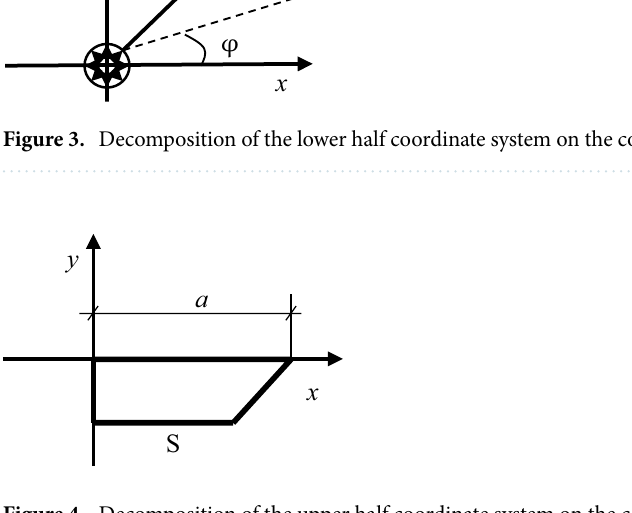
Figure 4. Decomposition of the upper half coordinate system on the complete contact